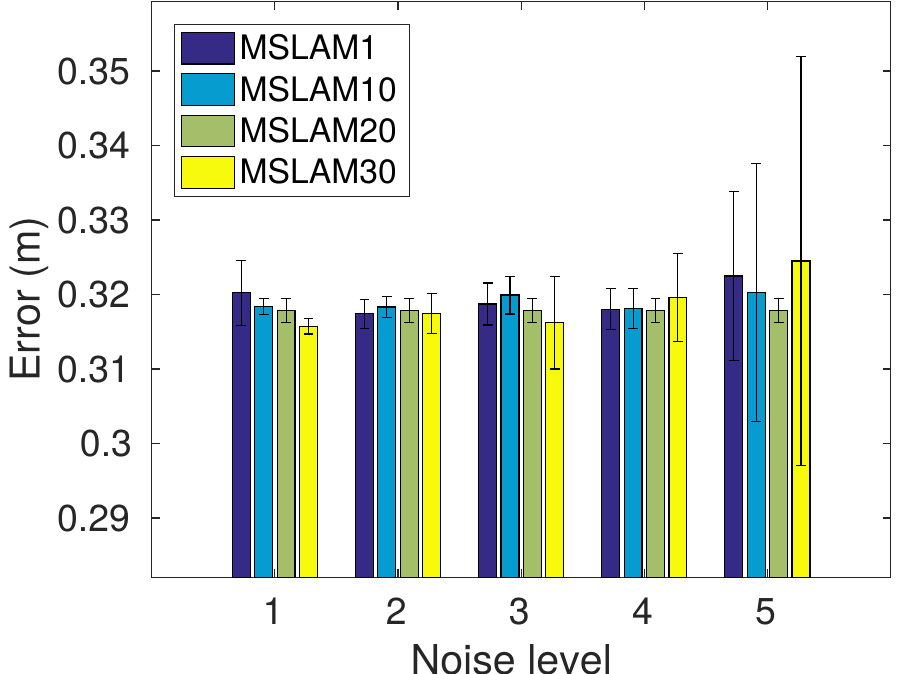
Figure 21. Global error depending on the noise level and the number of loops for map